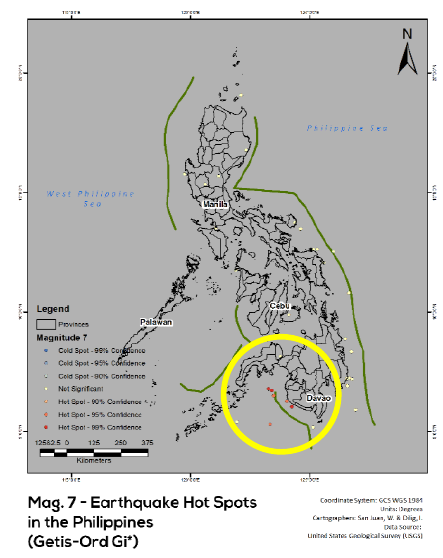
Figure 9. Mag.7-Earthquake Hot Spots in the